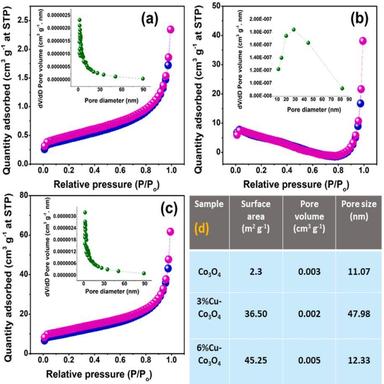
N2 adsorption-desorption isotherms and corresponding BJH pore-size distribution curves of Co3O4 (a), 3%Cu–Co3O4 (b), and 6%Cu–Co3O4 (c). Comparison of BET outcomes of undoped and Cu-doped samples (d).